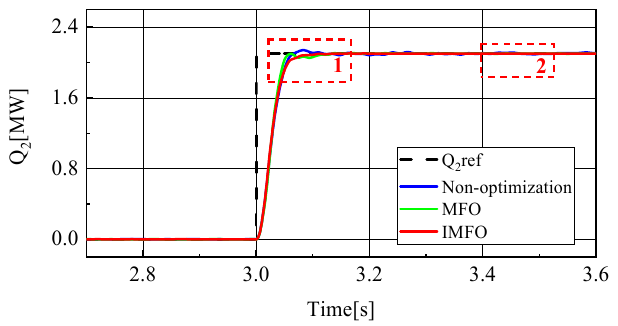
Figure 14. MMC2 reactive power waveform.